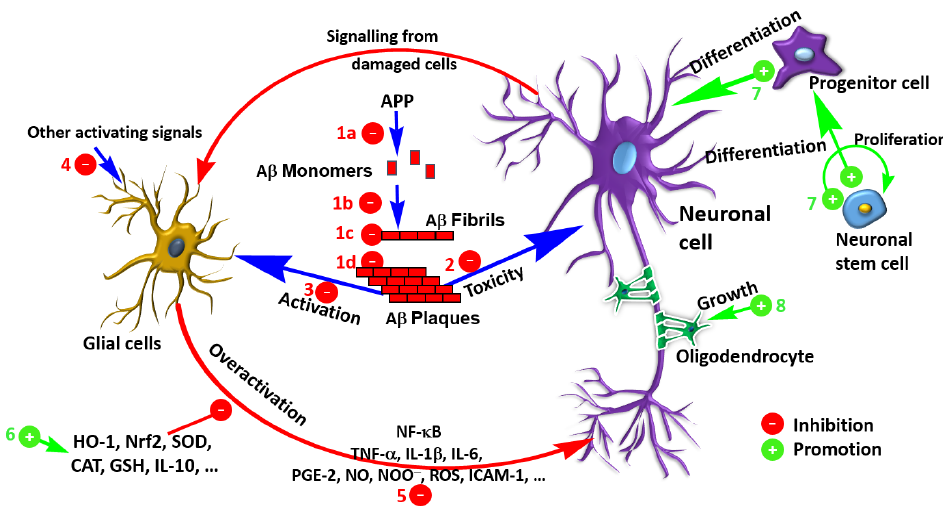
Figure 5. Overview of the therapeutic potential of salvianolic acids and RA derivatives in dementia